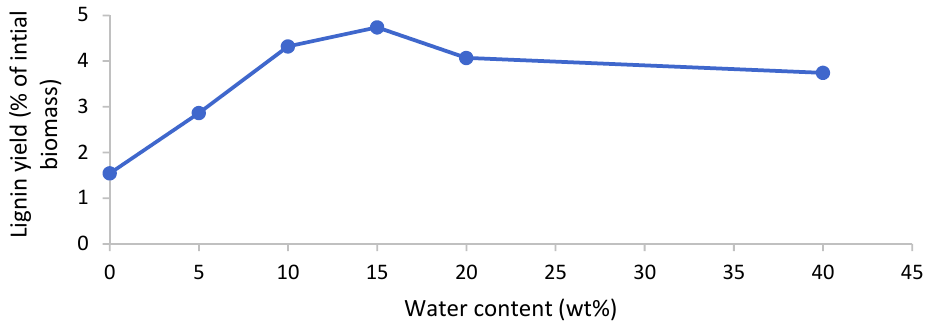
Figure 7. Lignin yield after pretreatment of the poplar with [EMim][HSO 4 ] containing 0–40 wt% water for 46 h at 100 °C.